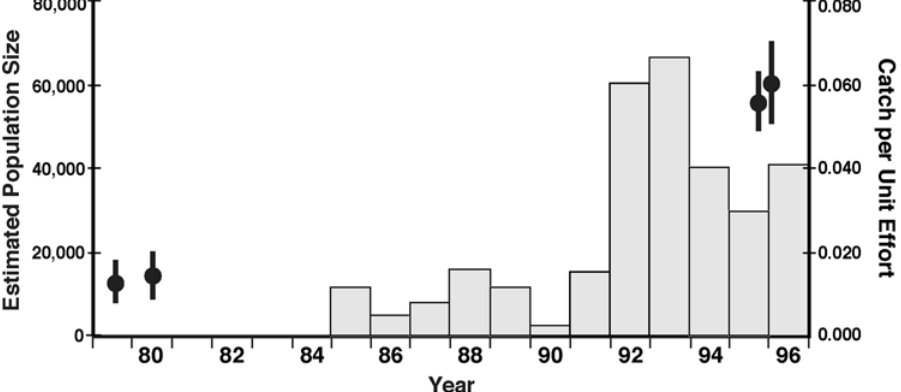
Figure 3. Population estimates and abundance trend for Hudson River shortnose sturgeon in the 1980s and 1990s. The paired symbols of circles (means) and heavy lines (95% confidence intervals) show the results of population estimates in the late 1970s and late 1990s. The catch per unit effort histogram bars are the average catch of shortnose sturgeon per trawl haul in a riverwide fish survey conducted annually by the Hudson River electric utilities.